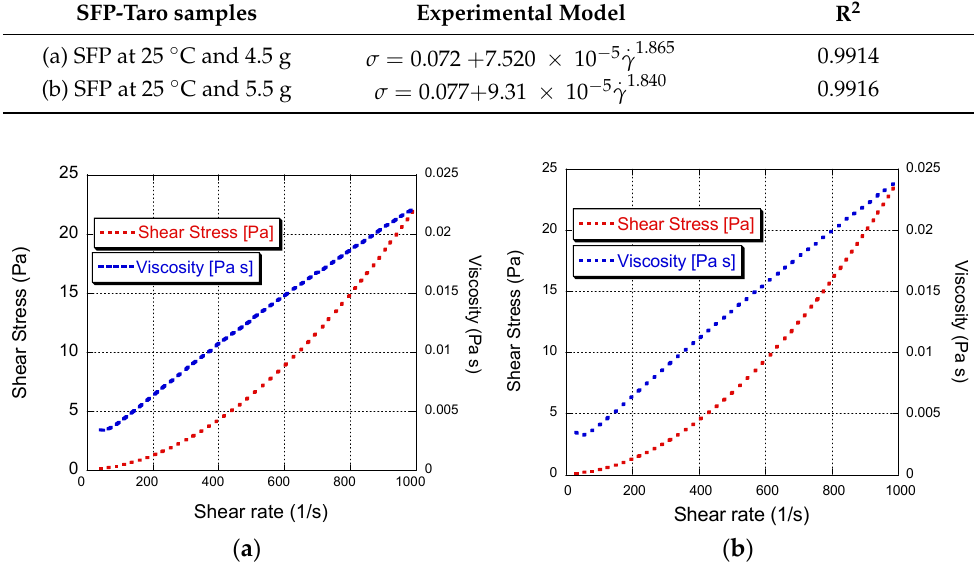
Figure 6 . Rheogram of cassava SFP at 25 °C at the two levels of starch concentration ( a ) 4.5 g and ( b ) Figure 6. Rheogram of cassava SFP at 25 ◦ C at the two levels of starch concentration ( a ) 4.5 g and ( b ) 5.5 g. 5.5 g . Table 6. Cassava SFP HB model at the two levels of starch concentration and 25 ◦ C. SFP-Cassava